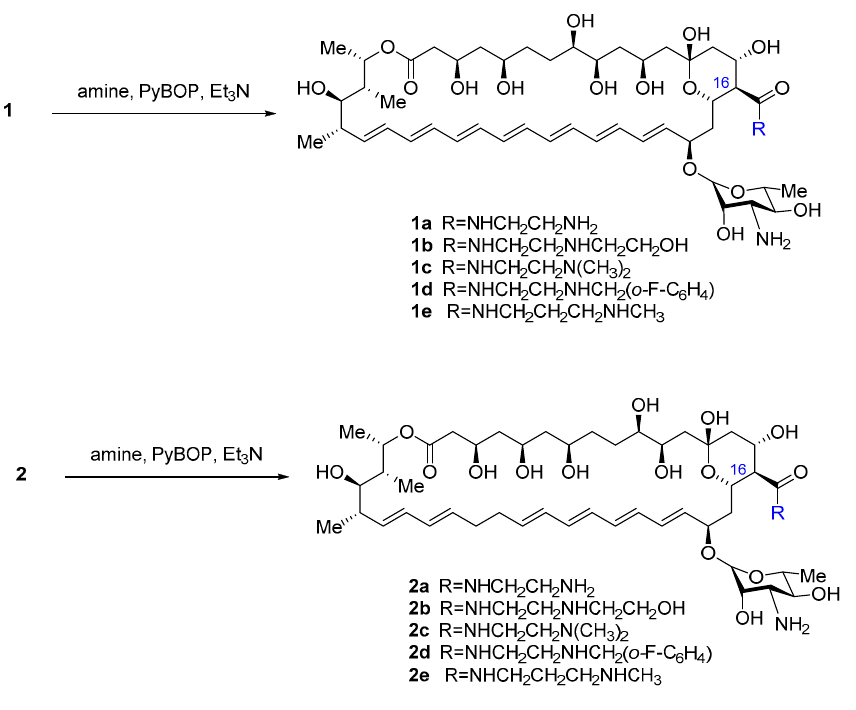
Scheme 1. Synthesis of polyene antibiotic